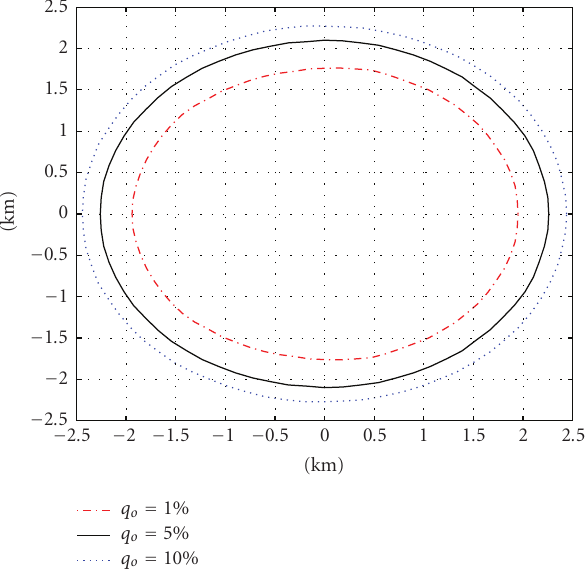
Figure 8: MIMO with antenna location (1,0) and ( −